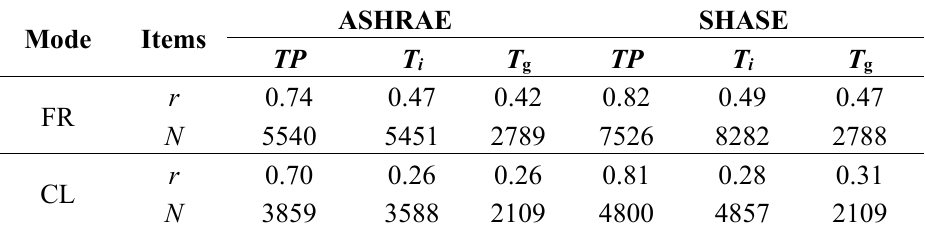
Table 5. Correlation coefficient with ASHRAE and SHASE scales.